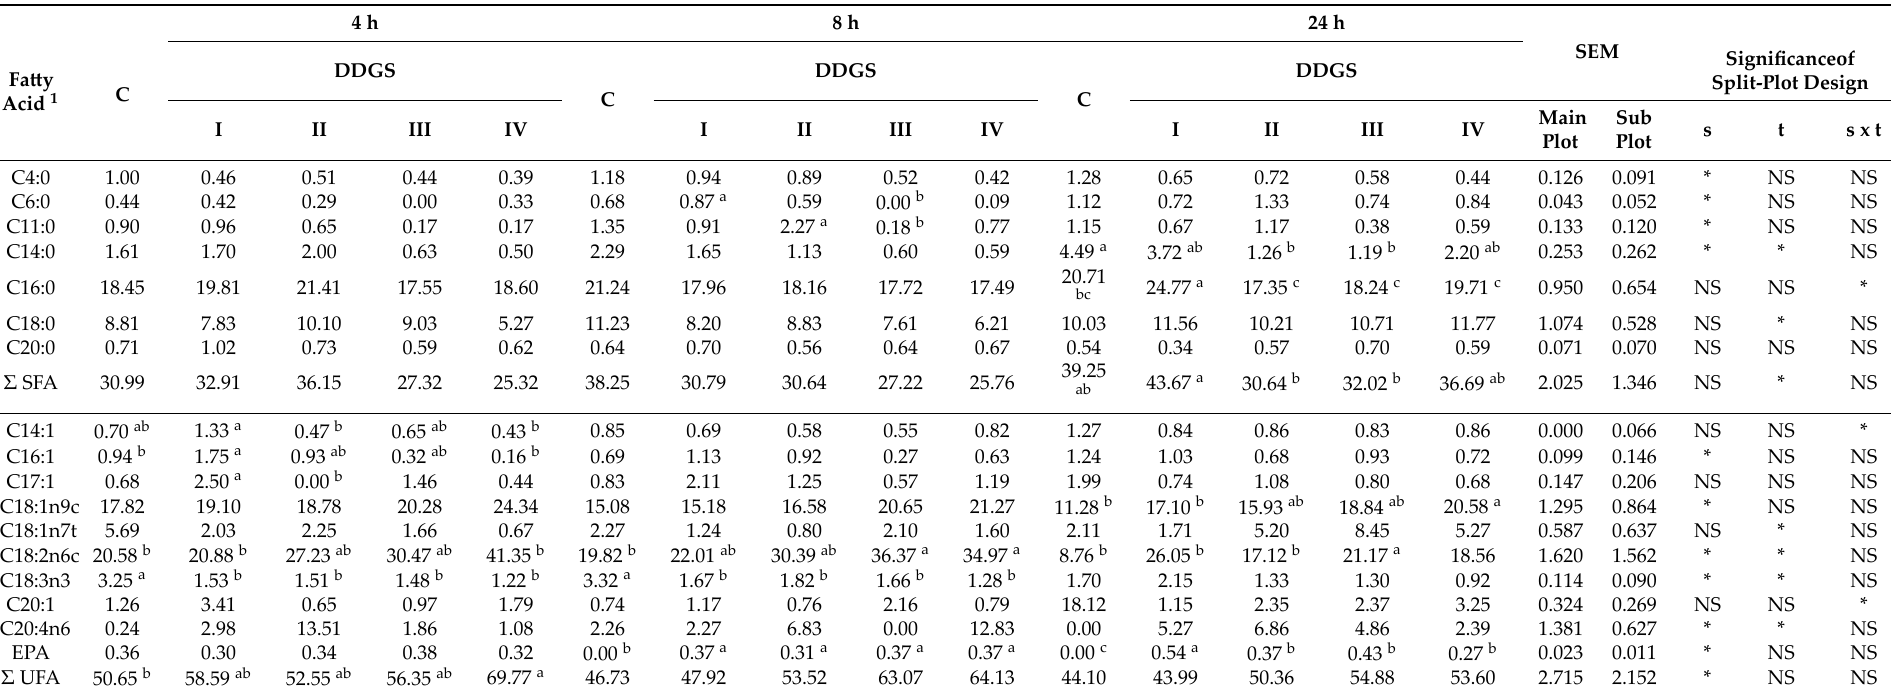
Table 3. Effect of time and the proportion of DDGS included in the substrate on saturated fatty acid levels in ruminal fluid incubated in vitro (n =